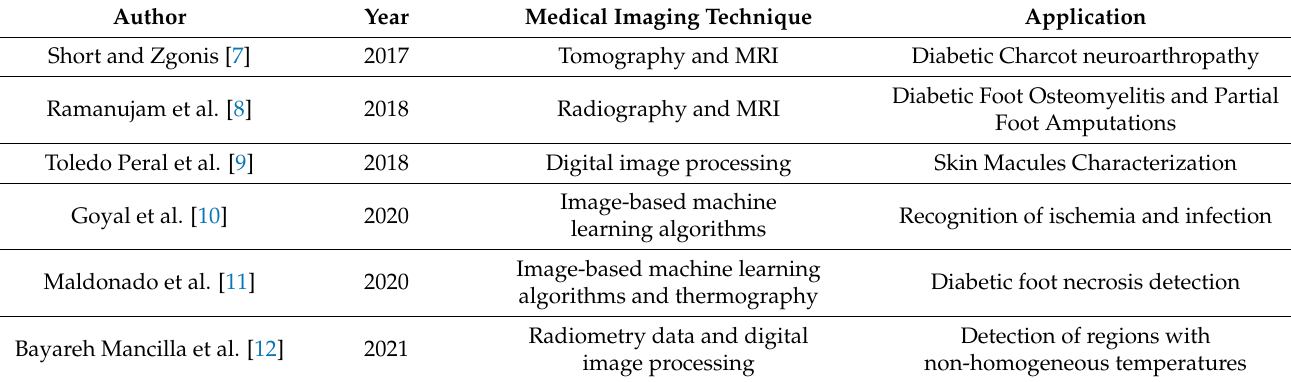
Table 1. State-of-the-art of medical imaging for DM complication studies on lower limb and foot.